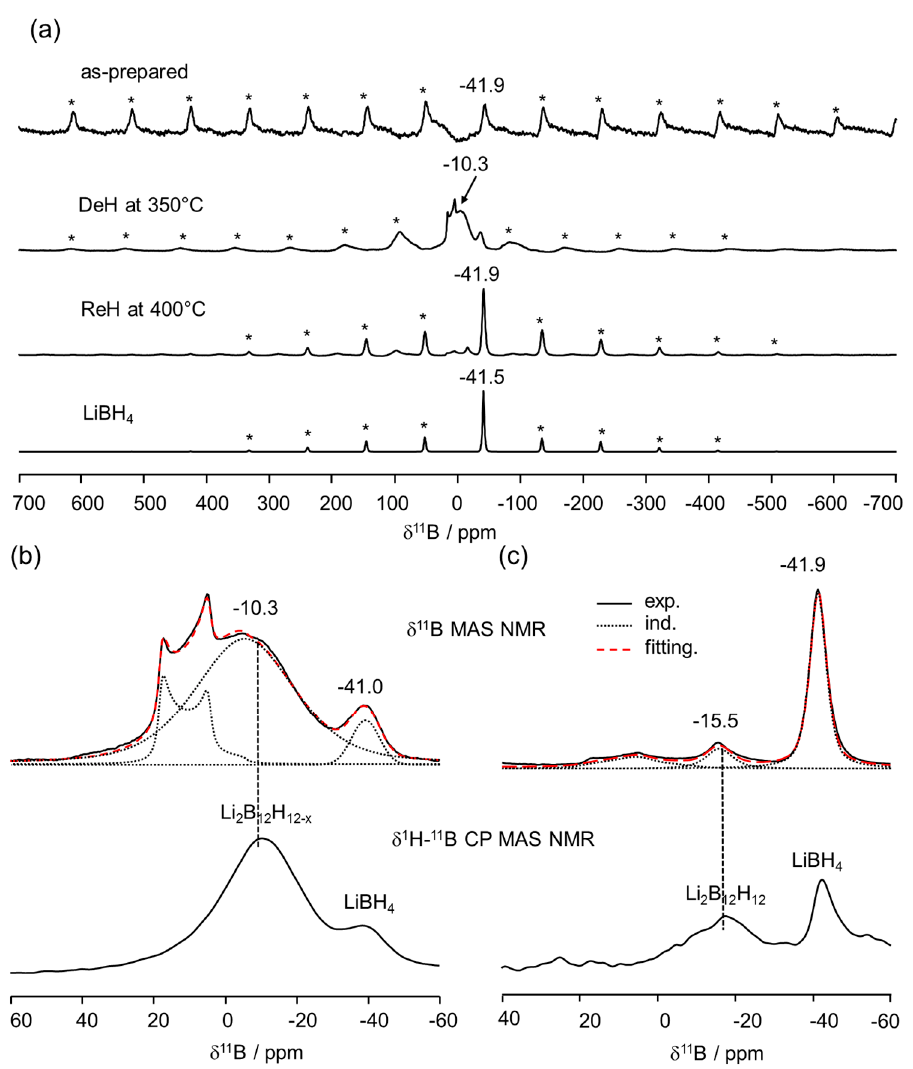
Figure 2. ( a ) Full range of 11 B MAS NMR spectra of LiBH 4 -Co 1.34 B composite at different reaction stages: as-prepared, dehydrogenated (DeH) at 350 °C, rehydrogenated (ReH) at 400 °C, and of pure LiBH 4 as reference; ( b , c ) 11 B MAS NMR and 1 H- 11 B CP-MAS NMR spectra of the LiBH 4 -Co 1.34 B composite dehydrogenated at 350 °C and rehydrogenated at 400 °C, respectively. The experimental data (exp.) are shown as solid, individual components (ind.) and fitting results as different dotted (···) and broken (---) lines, respectively. The stars (*) indicate spinning side bands.